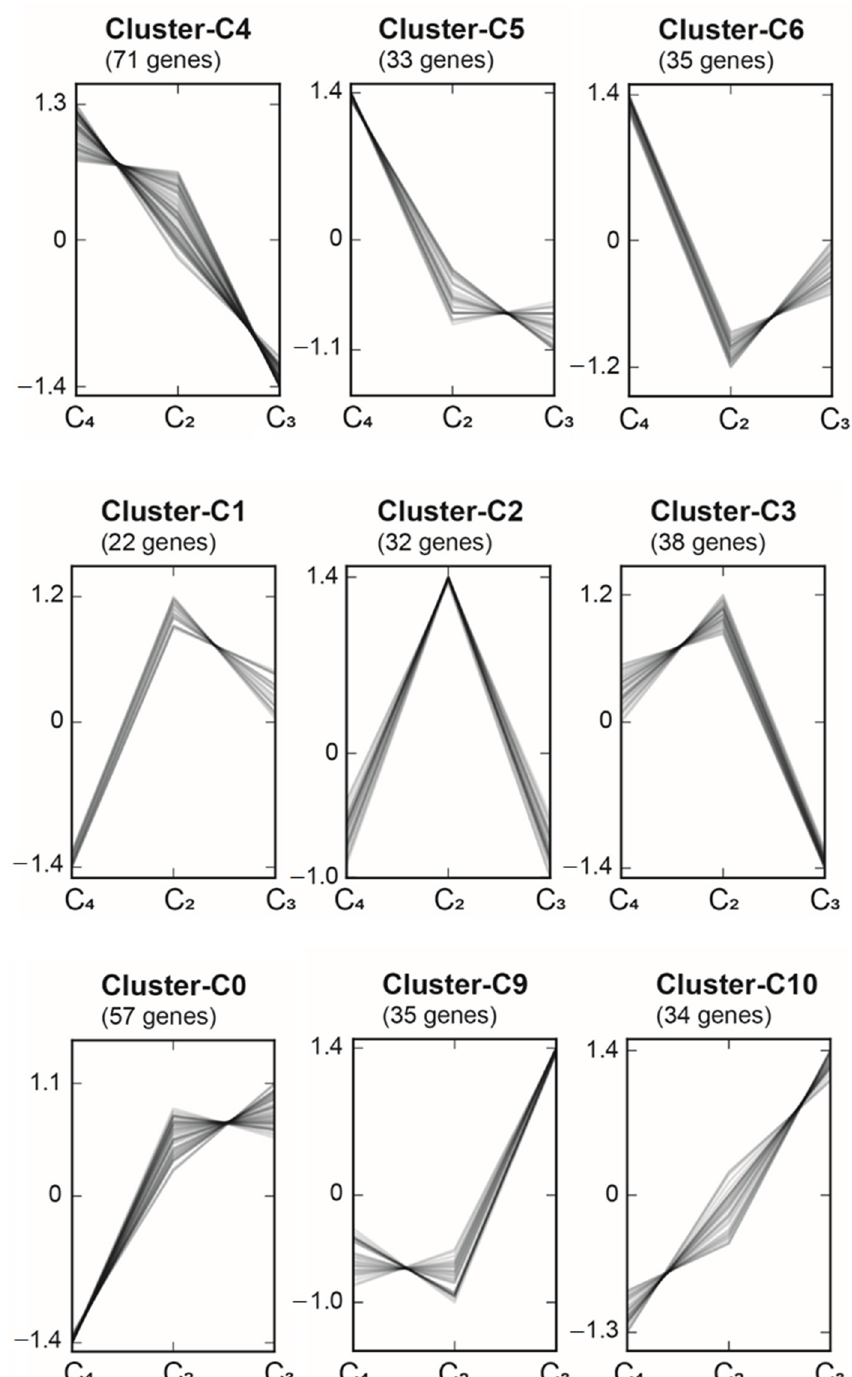
Figure 3. Co-expressed gene clusters were generated using Clust v.1.10.7 [33]. The eight species were grouped into three different conditions ‘C 4 species’, ‘C 2 species’, and ‘C 3 species’. The 11 clusters contained between 22 and 71 genes.